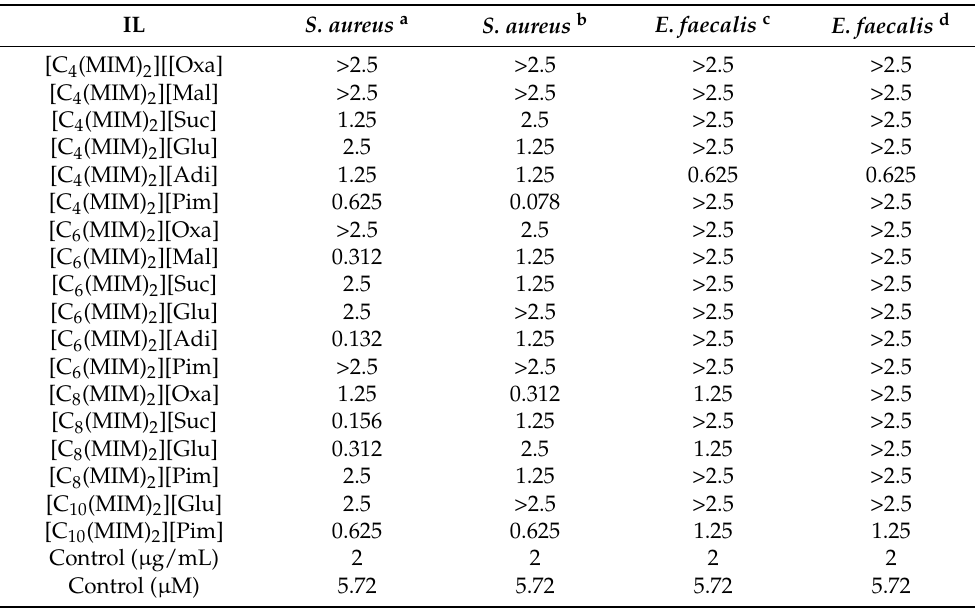
Table 4. MICs (in mM) of DILs against Gram-positive bacteria.